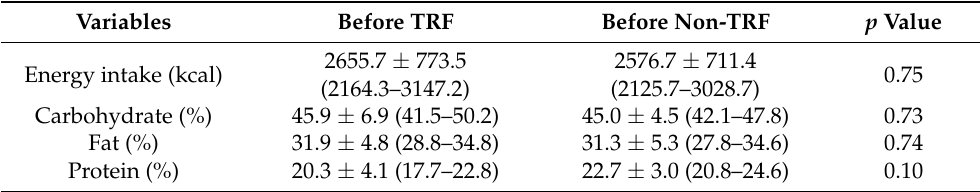
Table 1. Estimated daily dietary intake obtained four days before time-restricted feeding (TRF) and non-time-restricted feeding (non-TRF).